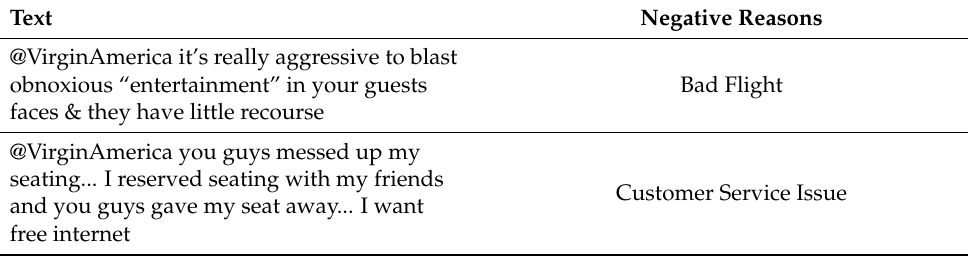
Table 2. Combining